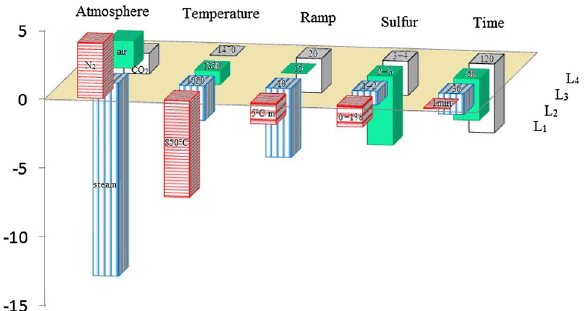
Fig. 5 Schematic illustration of Taguchi response for graphite- optimization of catalytic coke